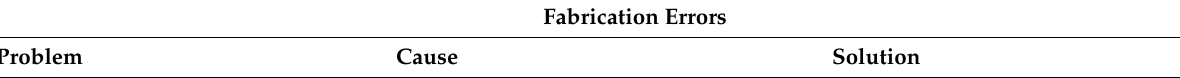
Table 1. Listed are the most frequently occurring challenges concerning fabrication errors with their respective cause and a suggested